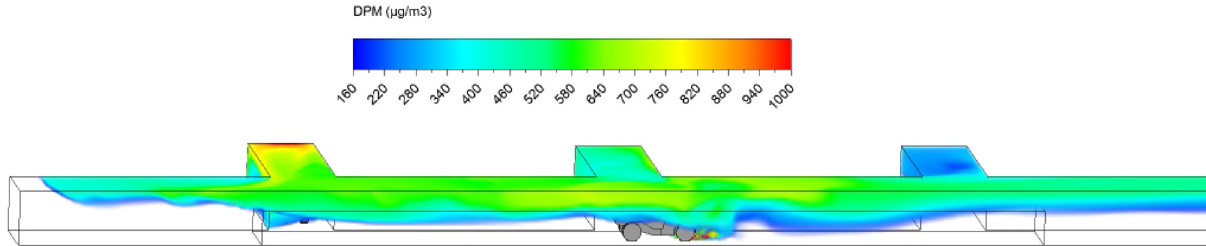
Fig. 17 DPM distributions in scenario 2 during the hauling operation at 210 s